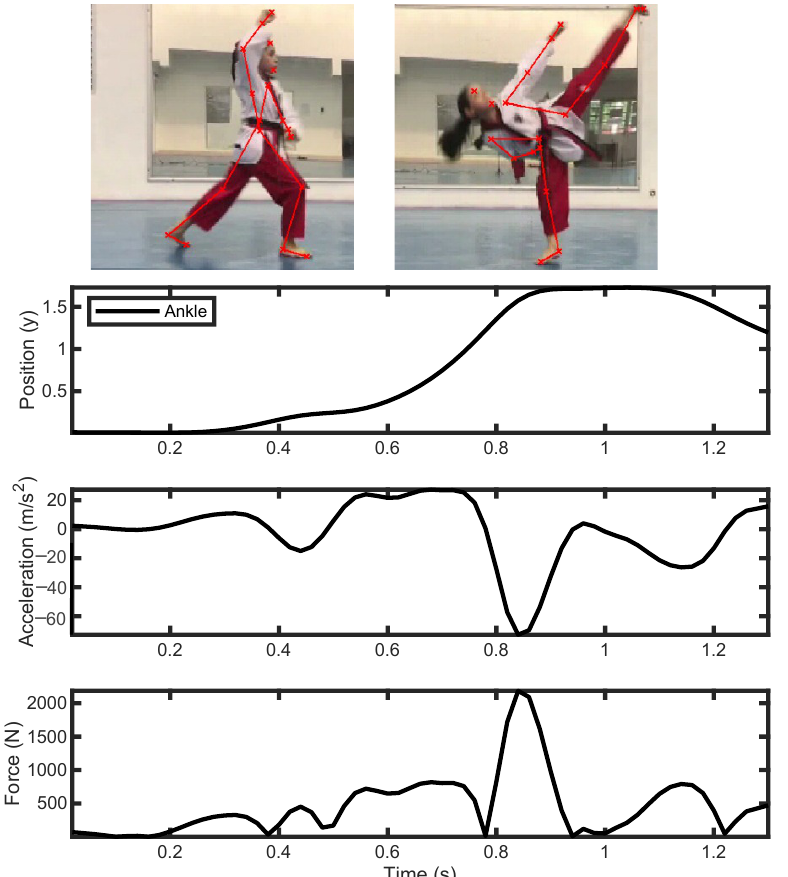
Figure 3. Temporal tracking of position, acceleration and estimated force of the left ankle of the taekwondoist during a high roundhouse kick. The insets at the top of the figure depict the sequence of movements that the taewkwondoist was performing; preparing stance, and high